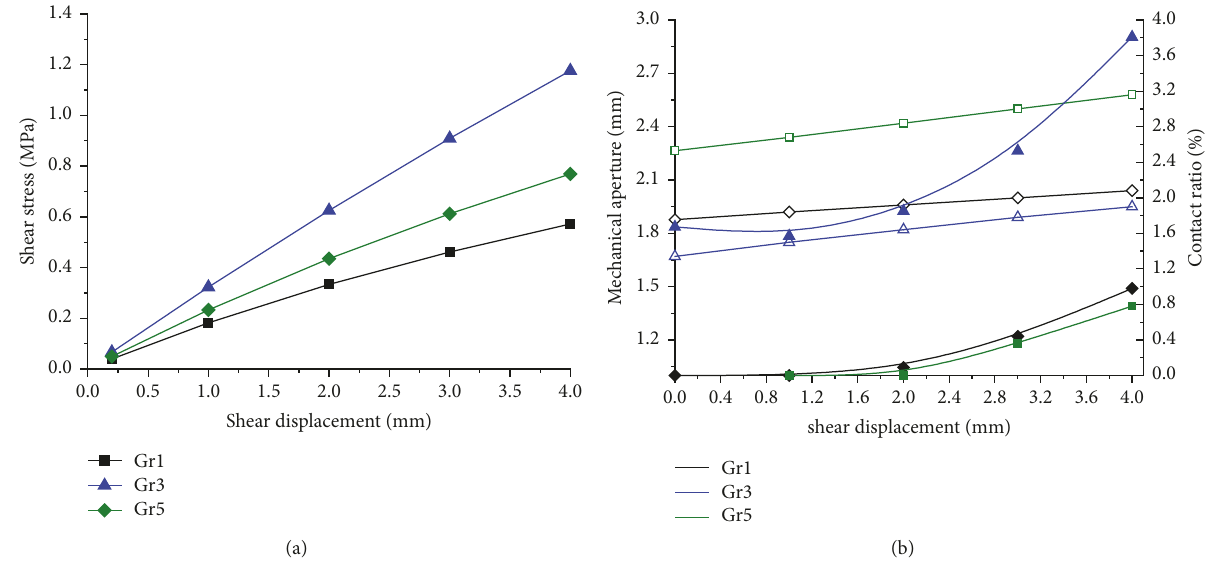
Figure 10: (a) Shear displacement against shear stress. (b) The change of fracture geometry during shear (solid points represent mechanical aperture and open points represent contact ratio).